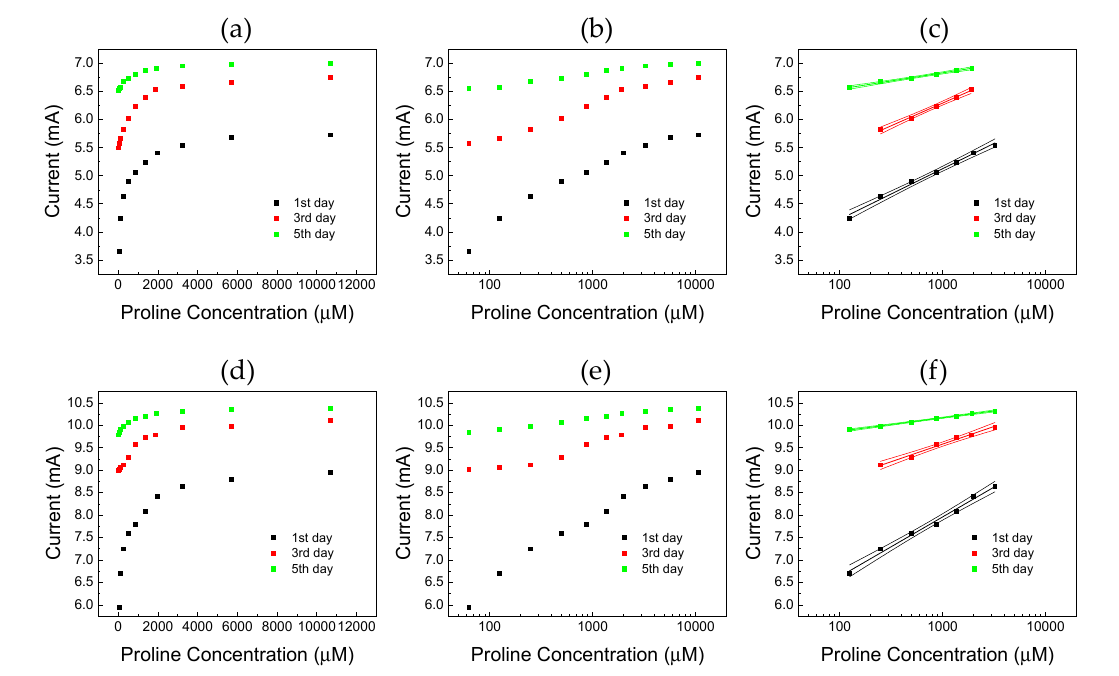
Figure 7. Calibration curves recorded at the first ( ■ ), at the third ( ■ ), and at the fifth ( ■ ) day from sensor assembly, obtained by increasing proline concentration between 63 μ mol L − 1 and 10.7 mmol L − 1 (H 2 O 2 concentration in solution equal to 1.5 mmol L − 1 ) and reading the intensity current values at the maximum of oxidation ( a – c ) and reduction ( d – f ) peaks of CV curves. Curves ( a , d ), plotted using linear axes, show logarithmic trends; curves ( b , e ), plotted on semilogarithmic scales, show about linear trends; ( c , f ) straight-line intervals of curves ( b , e ). Each point represents the mean three determinations.